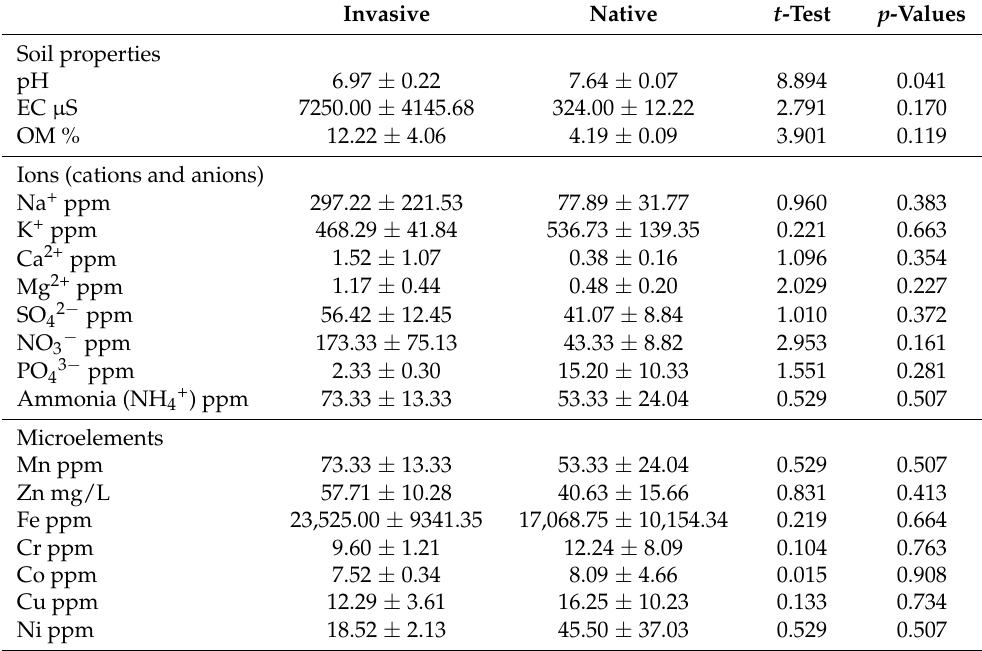
Table 3. Soil properties, ion concentrations, and microelement concentrations of soils in stands invaded by Leucaena leucocephala and adjacent stands with native vegetation in southwest Saudi Arabia. Invasive